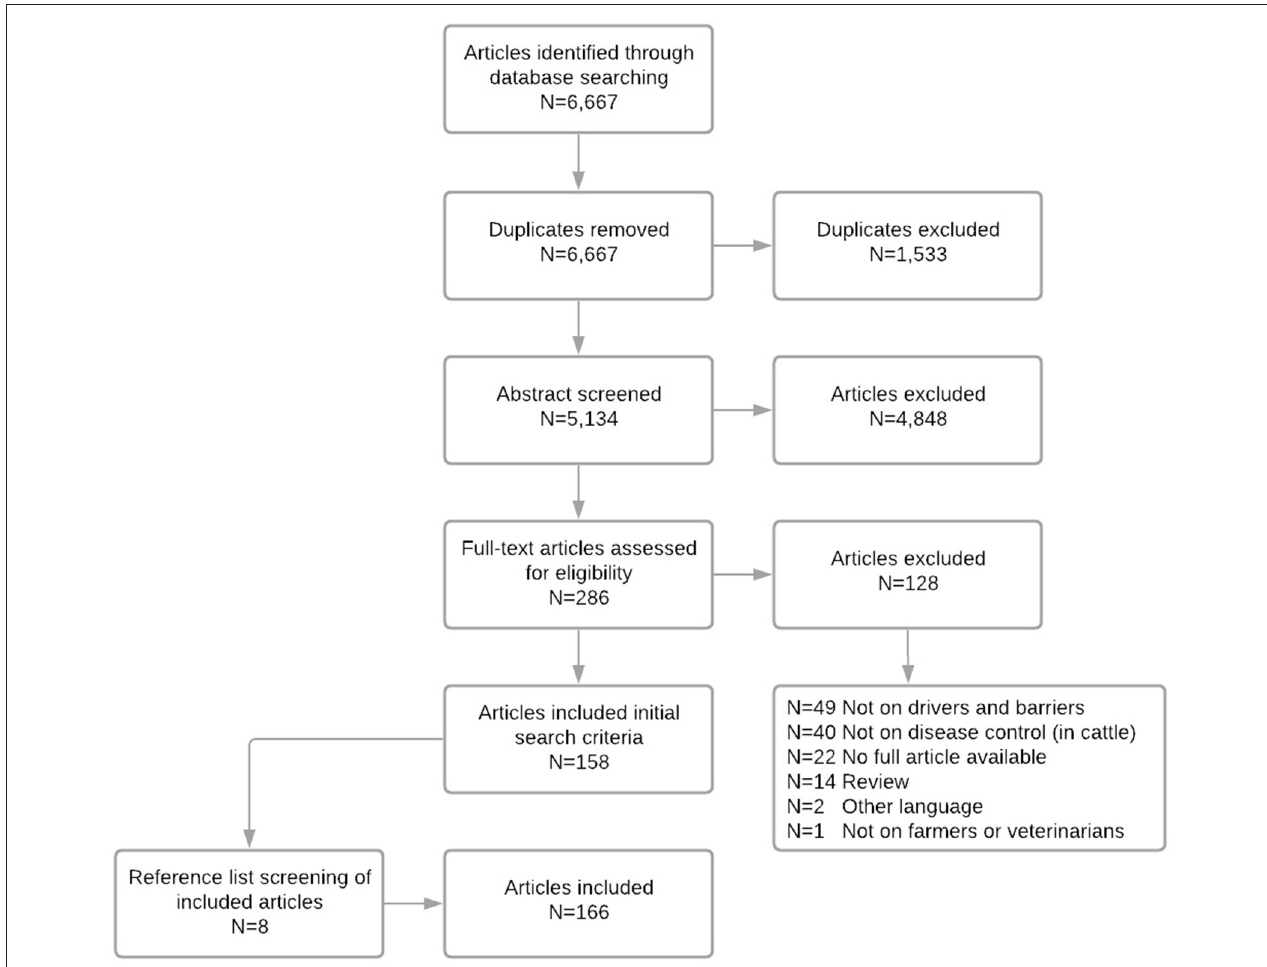
FIGURE 2 | Prisma flow-chart of included